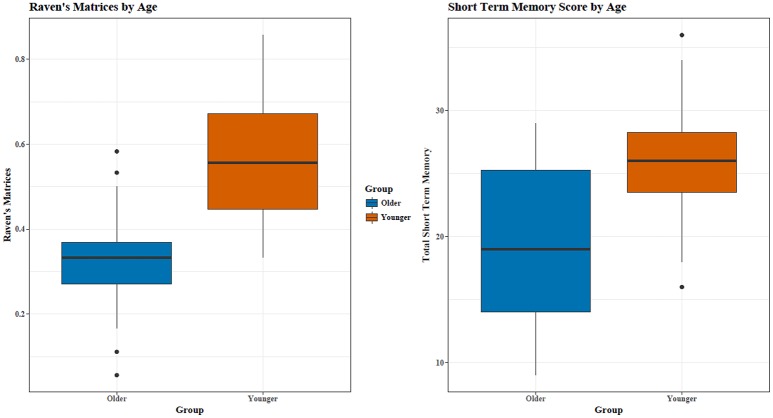
Young adults had significantly higher RM and STM scores. Outliers are represented by *.